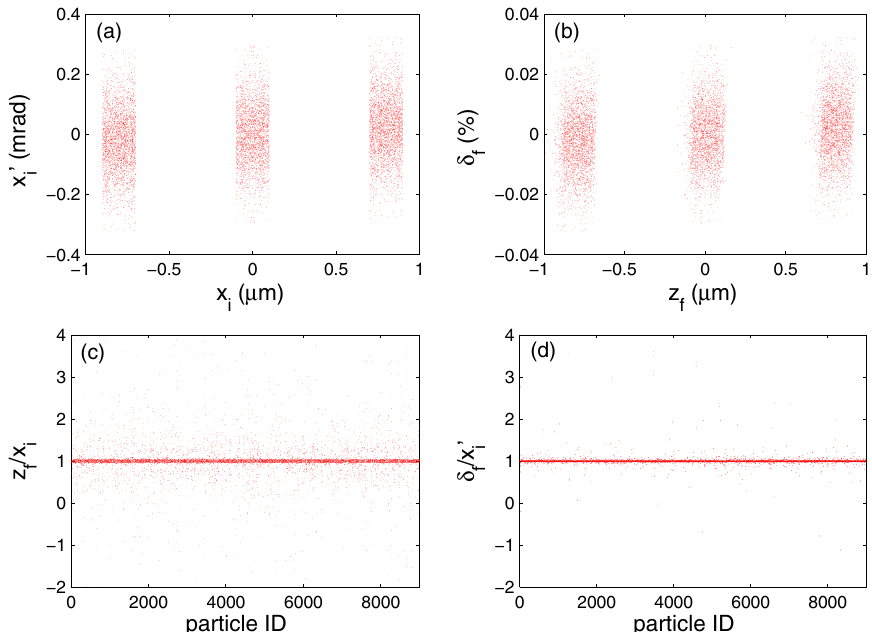
FIG. 6. (a) Initial transverse phase space after the mask. (b) Final longitudinal phase space after PSEX. (c) Ratio of z f to x i . (d) Ratio of (cid:1) f to x 0 i